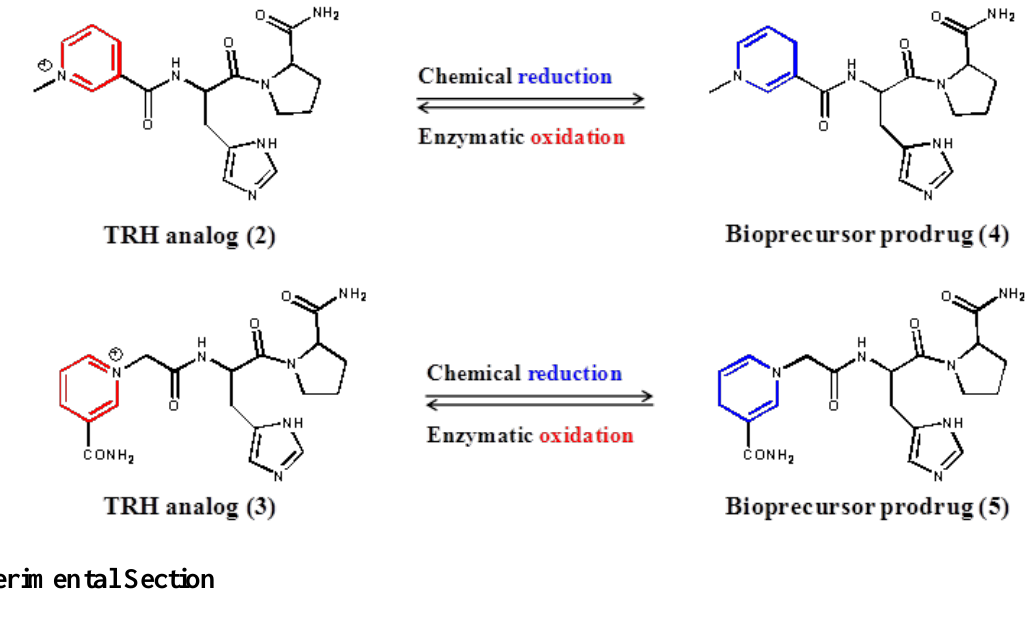
Figure 2. Chemical structures of novel TRH analogs ( 2 and 3 ) and their brain-targeting bioprecursor prodrugs ( 4 and 5 , respectively), as well as schematic illustration of prodrug synthesis from and their bioactivation to the respective TRH